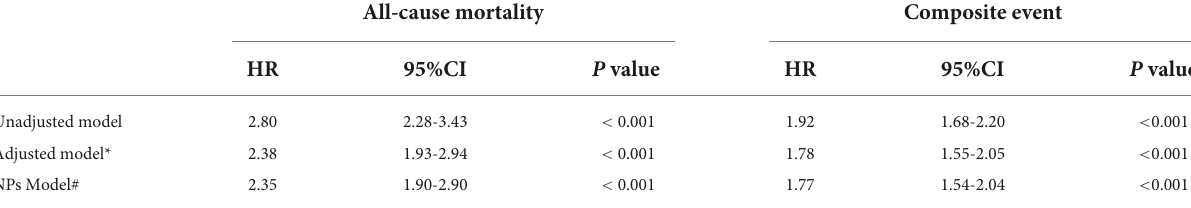
TABLE 2 The associations of depression with all-cause mortality and the composite event (death or HF rehospitalization). All-cause mortality Composite event